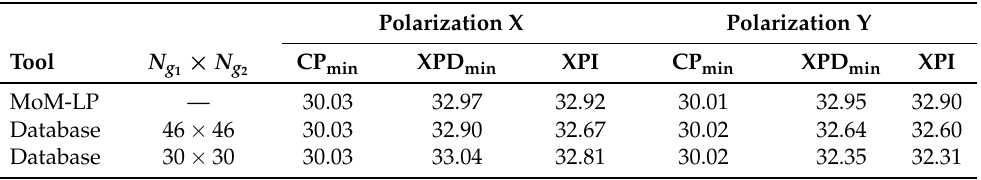
Figure 9. Evolution of the relative error in the ( a ) copolar and ( b ) crosspolar components of the radiation pattern when the number of samples in the database and SVR surrogate model per ( θ , ϕ ) pair varies. The dashed line represents the relative error when the database calculates the magnitude of the direct coefficients ρ xx and ρ yy from their interpolated real and imaginary parts instead of directly interpolating its magnitude (solid line). Table 6. Comparison of the figures of merit of a European-coverage pattern for different values in the N g total number of database entries N g = N g . CP min is in dBi and XPD min and XPI are in 2 1